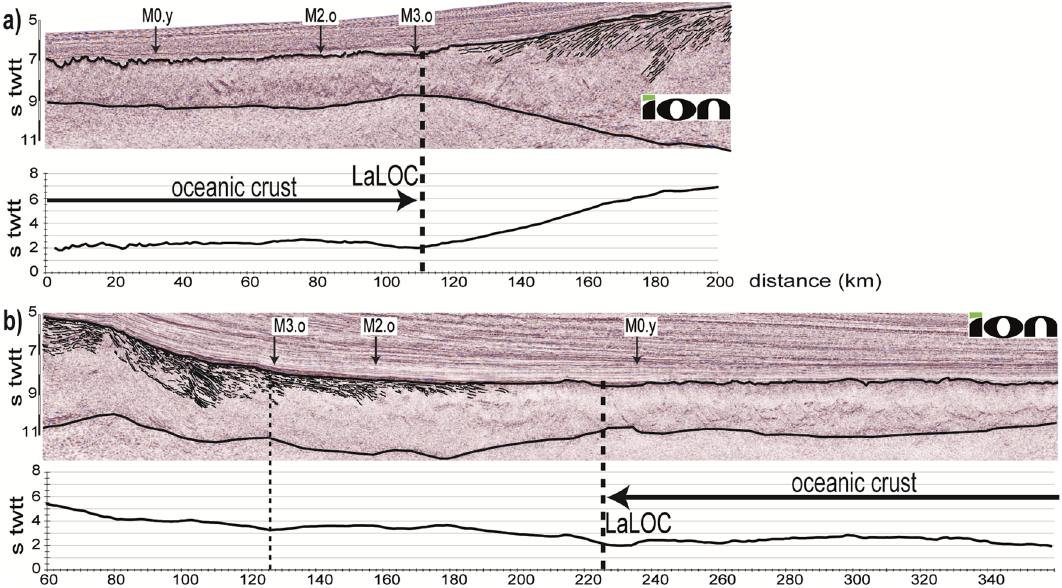
Figure 4. Crustal thickness variations (bottom panel) across the Landward Limit of Oceanic Crust (LaLOC) for two seismic reflection profiles (top panel) at the West African margin ( a ) and the South American margin ( b ). Vertical exaggeration of the seismic reflection profiles: ~ 2x (see Fig. 2 for location, the two lines are not conjugated). Thick black lines indicate the top of basement and Moho while thin black lines show SDRs in the seismic reflection profiles. Courtesy of ION